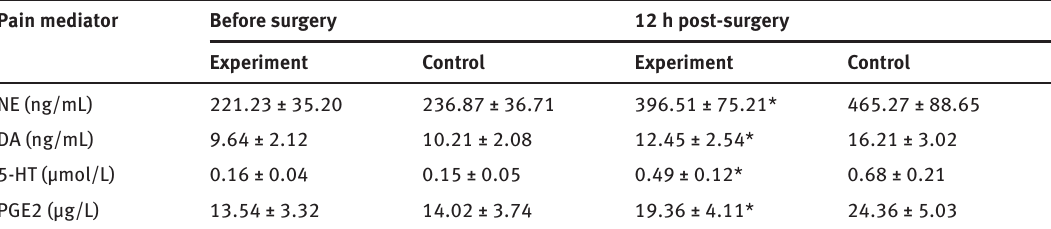
Figure 2: Scatter plot of sulfentanyl dosage and analgesic pump pressing times distribution (A: sulfentanyl dosage; B: analgesic pump pressing times). Table 3: Serum NE, DA, 5-HT, and PGE2 comparison of the two groups ( sx ±